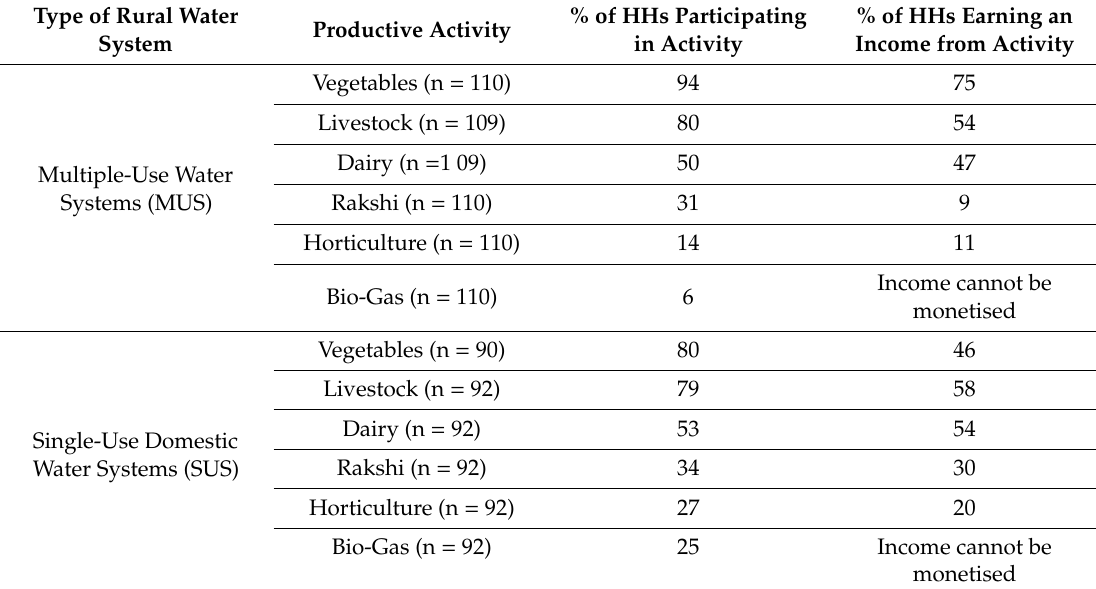
Table 4. Distribution of household participation in productive activities.